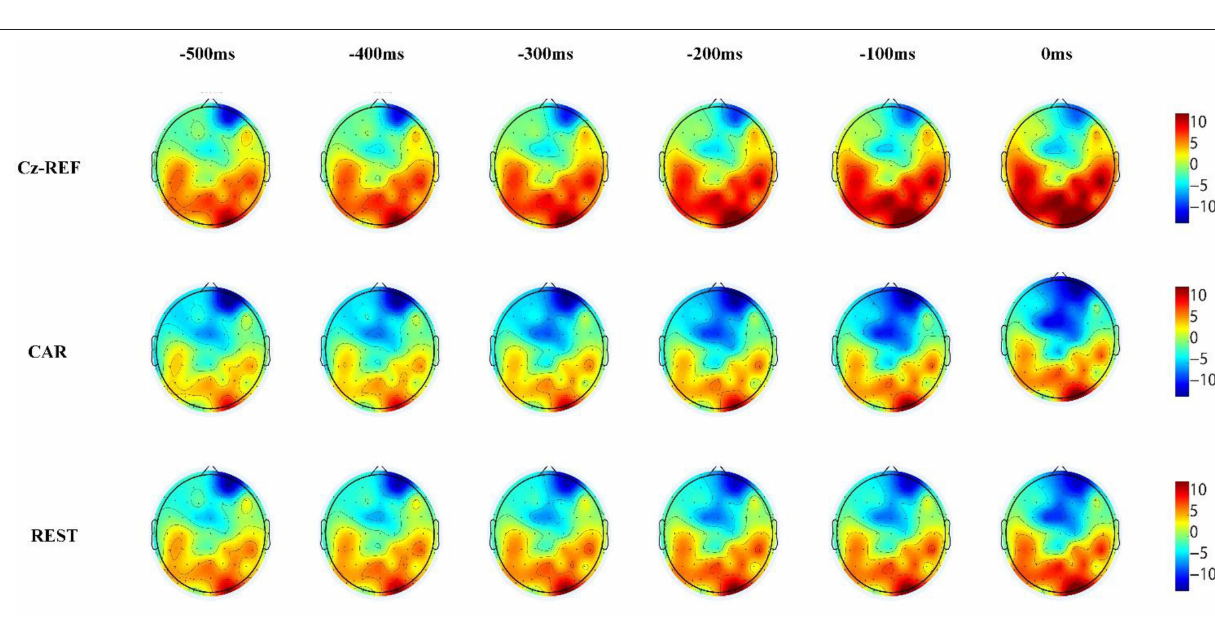
FIGURE 7 | Voltage topographies of S7’s right hand movement RP in three references.